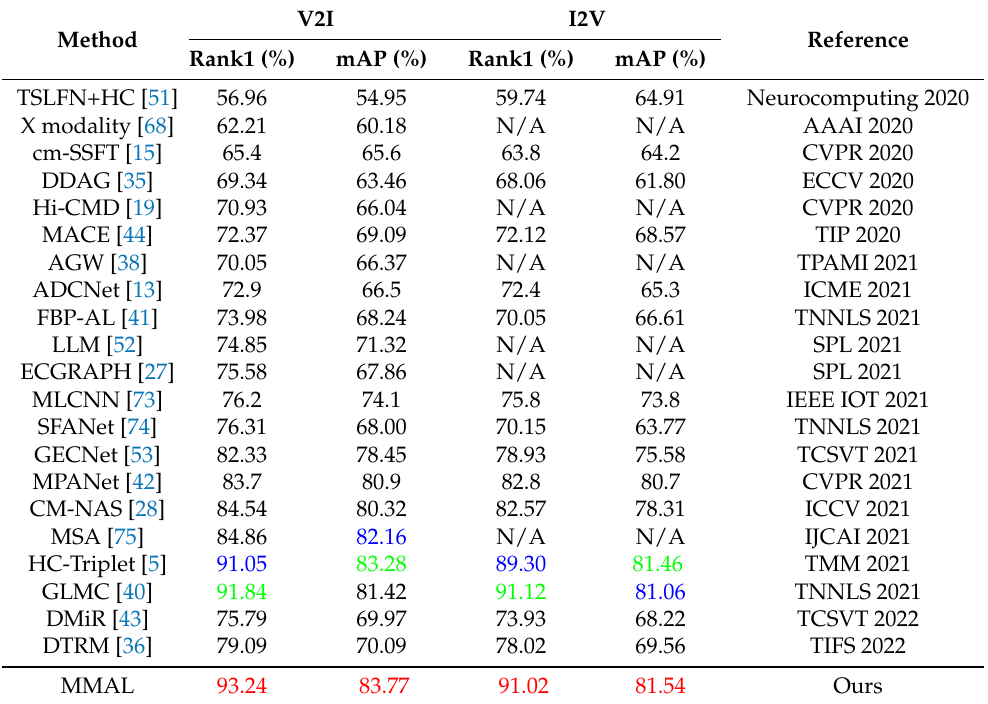
Table 1. The performance comparison of our MAL and state-of-the-art methods on the RegDB dataset. The V2I and I2V denotes the visible-to-infrared and infrared-to visible retrieval modes. The red, green and blue rows represents the 1st, 2nd and 3rd places, respectively.